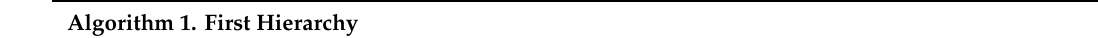
Algorithm 1. First Algorithm 1. First Hierarchy